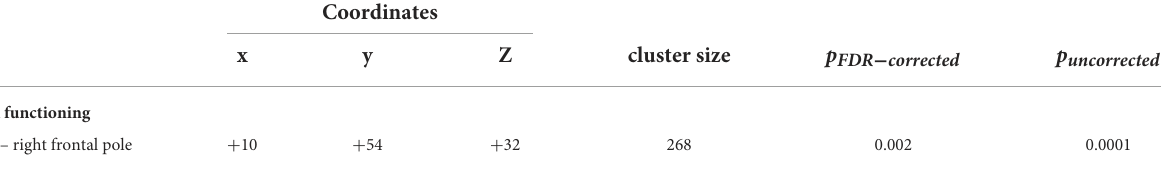
TABLE 2 Cerebellar seed to voxel connectivity